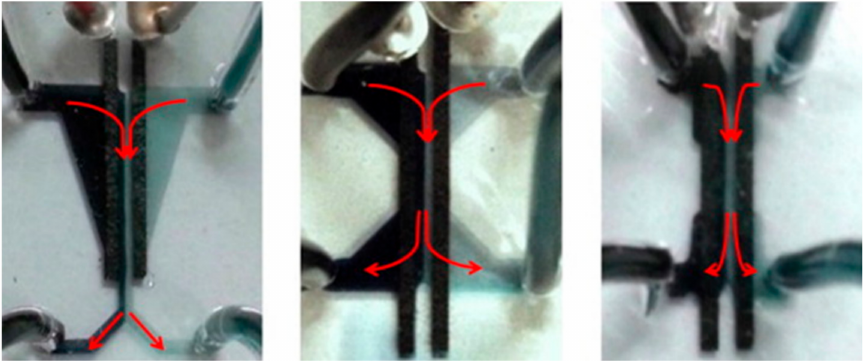
Figure 6. Reactant recirculation in MMFC (reprinted from ref. [122]. Copyright 2014